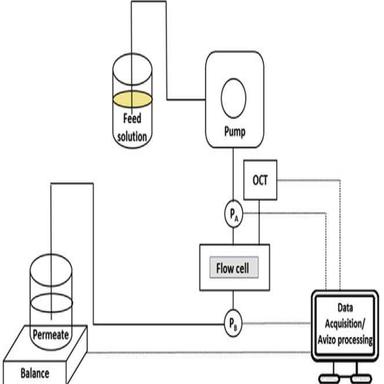
Schematic of the experimental setup. The flow cell was operated in dead-end mode at Q = 15 mL/min.